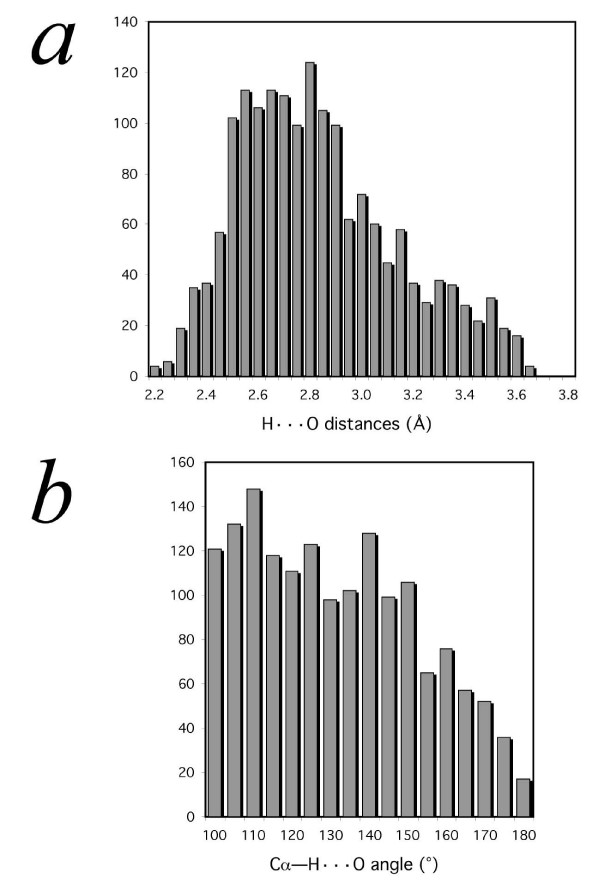
Distribution of H···O distances (a) and Cα-H···O angles (b) for the 1688 instances of single Gly-Cα-H···O hydrogen bonding in crystal structures of the Cambridge Structural Database (July 2003 release).